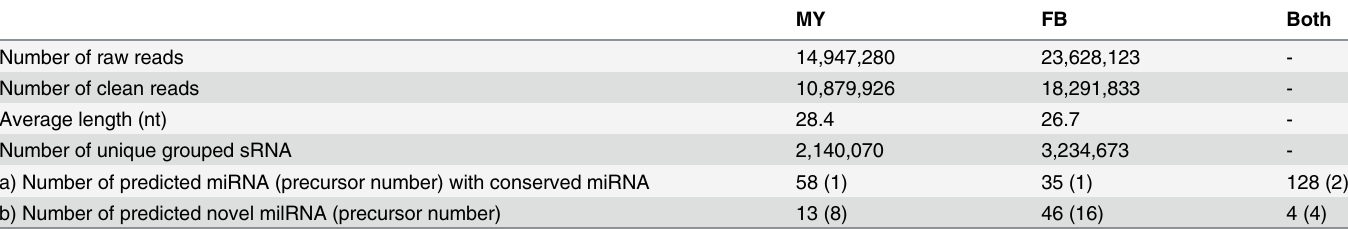
Table 2. General features of small RNA sequencing from different states of A . cinnamomea .